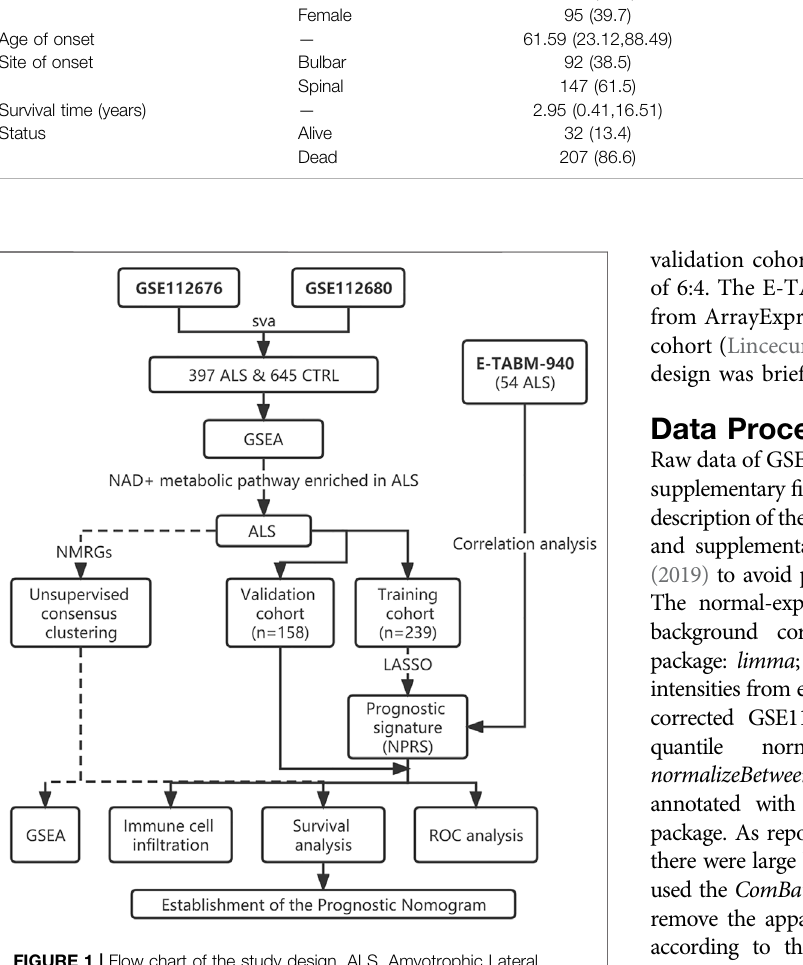
Frontiers in Cell and Developmental Biology |